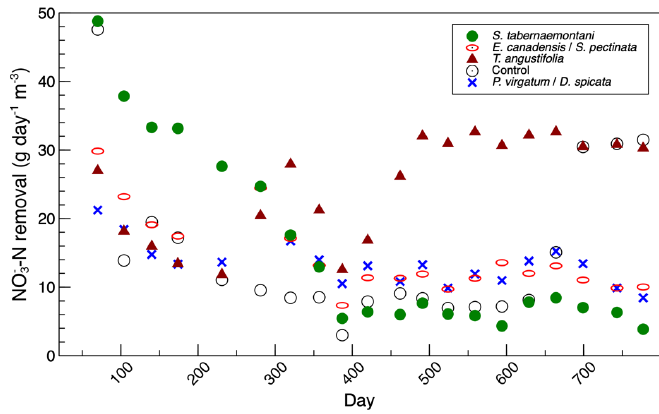
Figure 4. Temporal trend of nitrate mass removal rates.